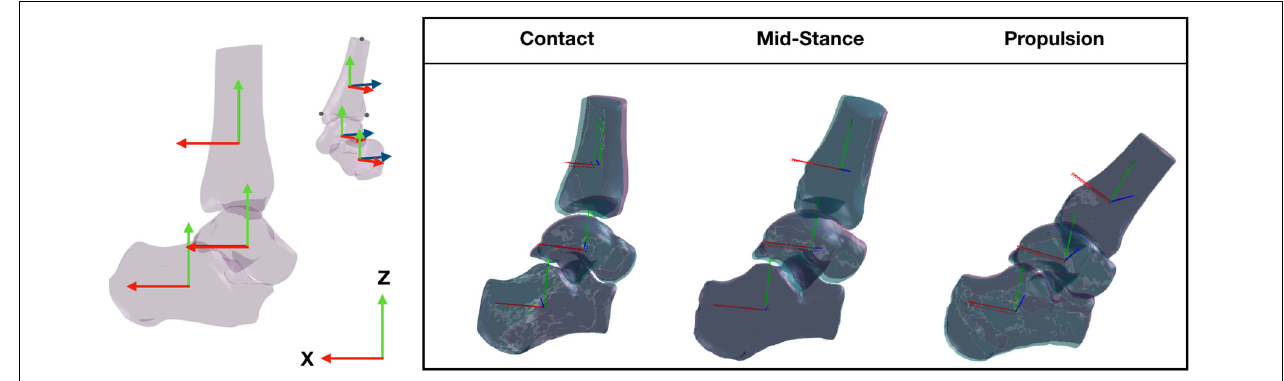
FIGURE 2 | Three dimensional bone model of the tibia, talus, and calcaneus and their tracking solutions processed across two sessions, session 1 (purple bones) and session 2 (aqua bones) tracked by the same operator. The local coordinate system of each bone illustrated by the solid red (x-axis), blue (y-axis), and green (z-axis) lines were created using virtual markers on the medial malleolus, lateral and superior most aspect of the tbia and transformed across the gait cycle according to the tracking solution.